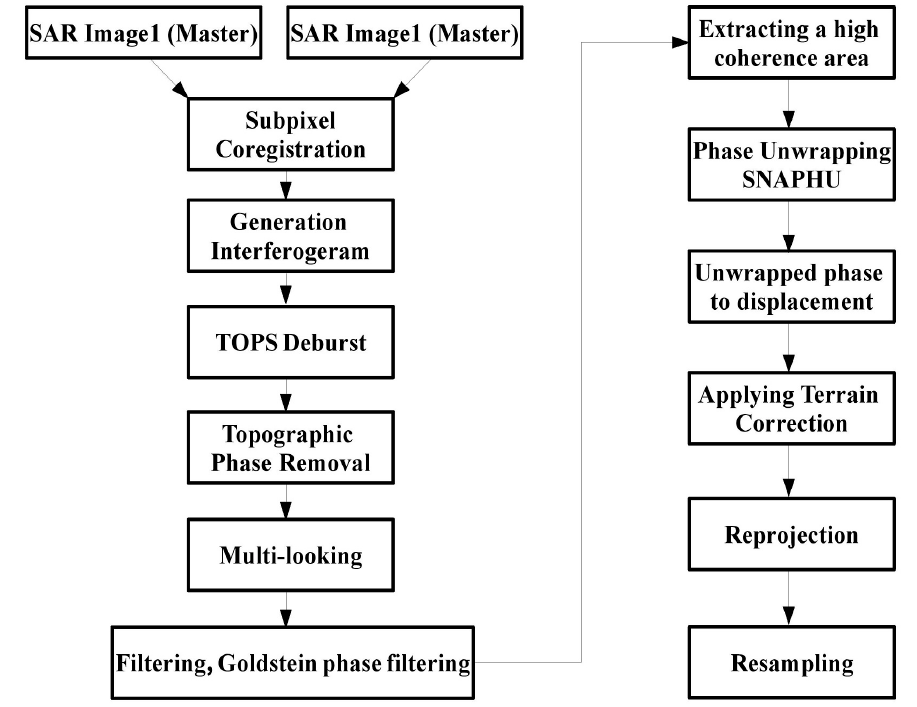
Figure 6. Methodology steps: A schematic block diagram for producing an interferogram and displacement map.